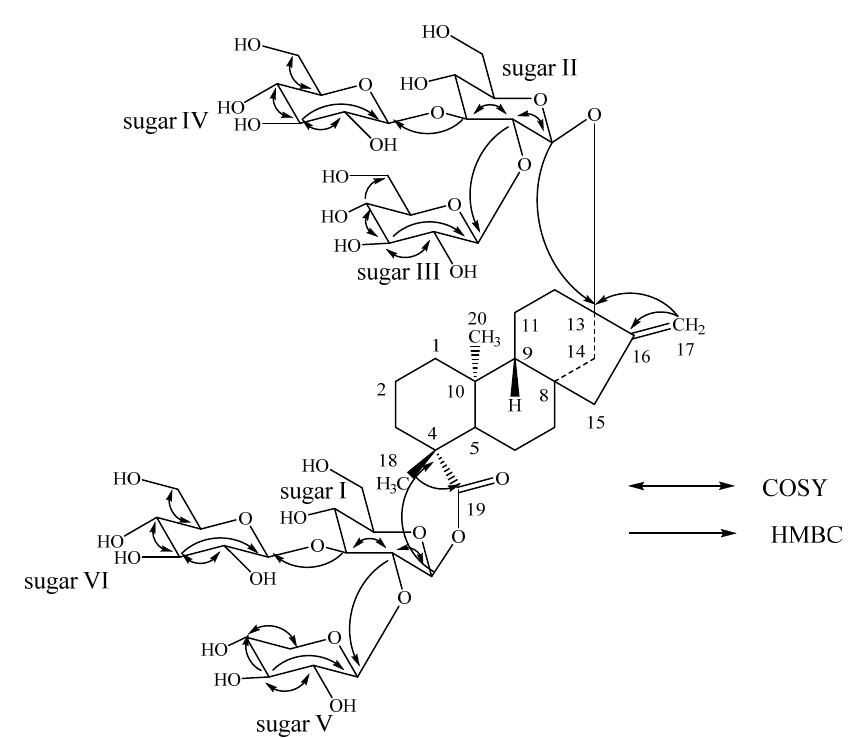
Figure 2. Key COSY and HMBC correlations of 1